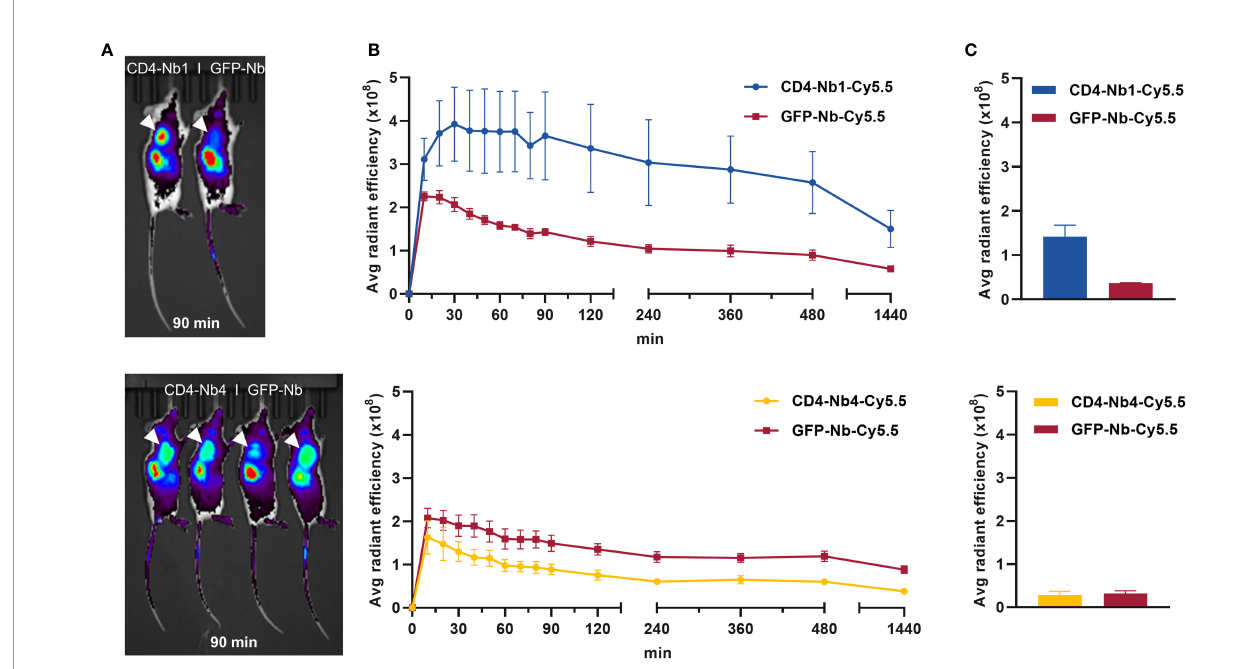
FIGURE 5 | In vivo optical imaging (OI) with CD4-Nbs-Cy5.5. Here, 5 µg of CD4-Nbs-Cy5.5 (top) or CD4-Nb4-Cy5.5 (bottom) or GFP-Nb-Cy5.5 (top and bottom) were administered intravenously (i.v.) to subcutaneously human CD4 + HPB-ALL-bearing NSG mice, and tumor biodistribution was monitored by repetitive OI measurements over the course of 24h (A) Acquired images of each measurement time point of one representative mouse injected with CD4-Nbs-Cy5.5 (left) or GFP- Nb-Cy5.5 (right, ctrl). Red circles and white arrows indicate the tumor localization at the right upper fl ank. (B) Quanti fi cation of the fl uorescence signal from the tumors (n = 4 per group, arithmetic mean of the average radiant ef fi ciency ± SEM) determined at indicated time points. (C) After the last imaging time point, tumors were explanted for ex vivo OI, con fi rming increased accumulation of CD4-Nb1-Cy5.5 compared to the GFP-Nb-Cy5.5 (n = 2 per group, arithmetic mean ±